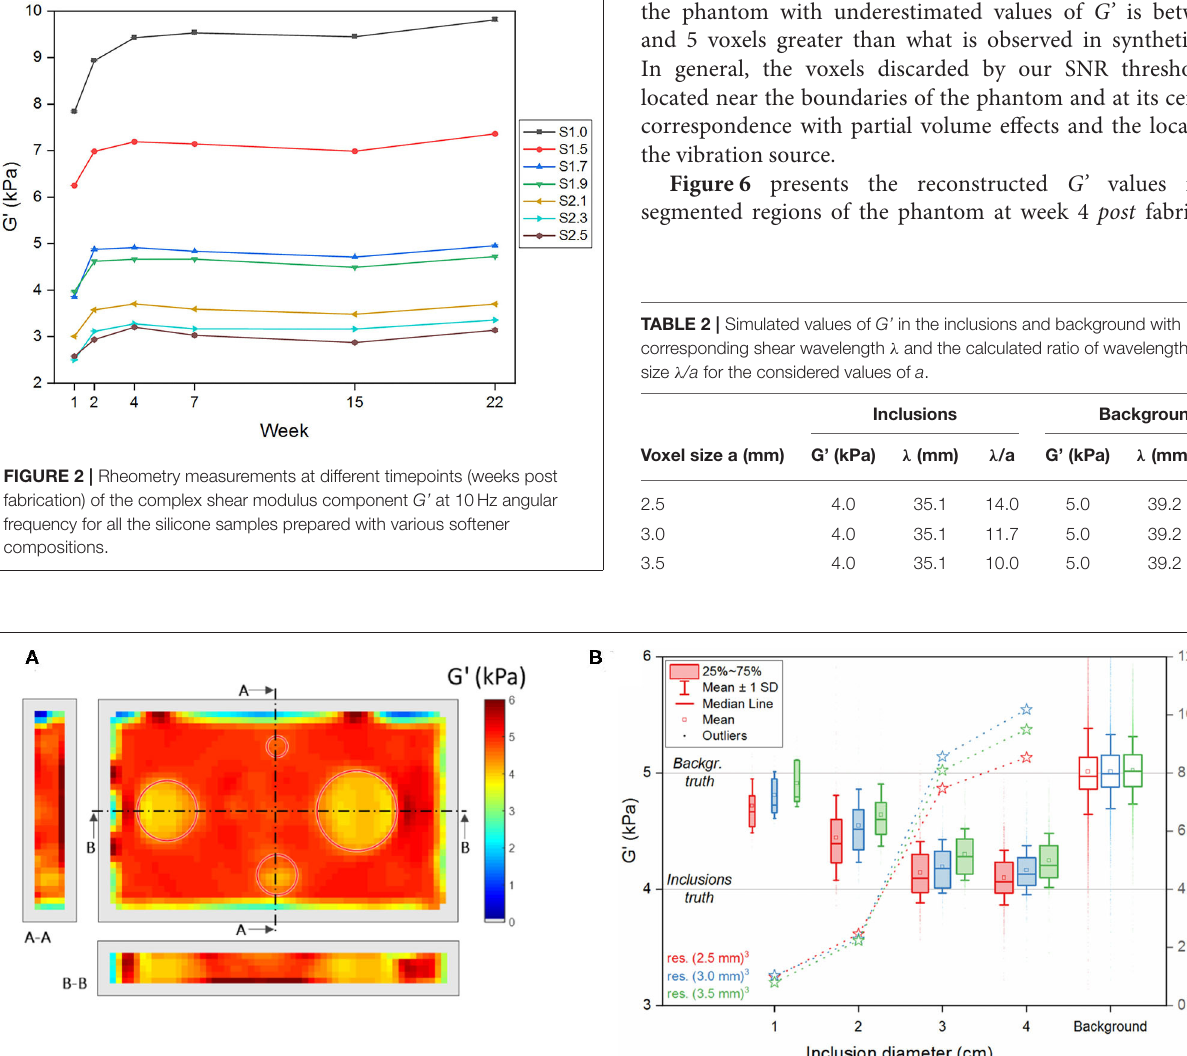
FIGURE 3 | Reconstructed component G’ of the complex shear modulus obtained from simulated data. (A) Example of a reconstructed 3D dataset at the central slice and its sections along the indicated lines A-A and B-B at 3-mm resolution (red circles: true position of the inclusions). (B) Summary of the values in all reconstructed voxels (over five slices) of the different segmented regions (inclusions I1, I2, I3, I4 and background) for all three considered voxel sizes (red: (2.5mm) 3 , blue: (3.0mm) 3 , green: (3.5mm) 3 ). The upper and lower edges of the boxes in the boxplot represent, respectively the first and the third quartile levels; horizontal line within the boxes: median value; square: mean value; whiskers: mean ± 1 standard deviation; outliers are indicated as dots. The horizontal lines across the plot represent the values set in the simulation for the different regions (see Table 2 ). Stars: contrast-to-noise ratio CNR between each inclusion and the background.